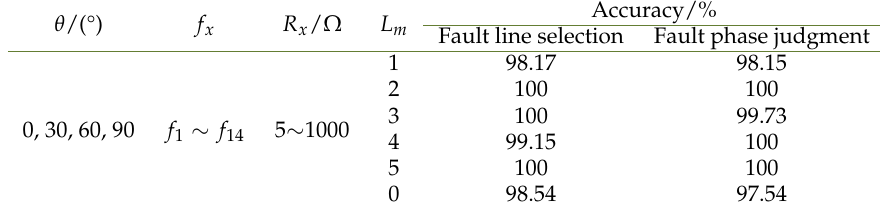
Table 11. Testing results of L 6